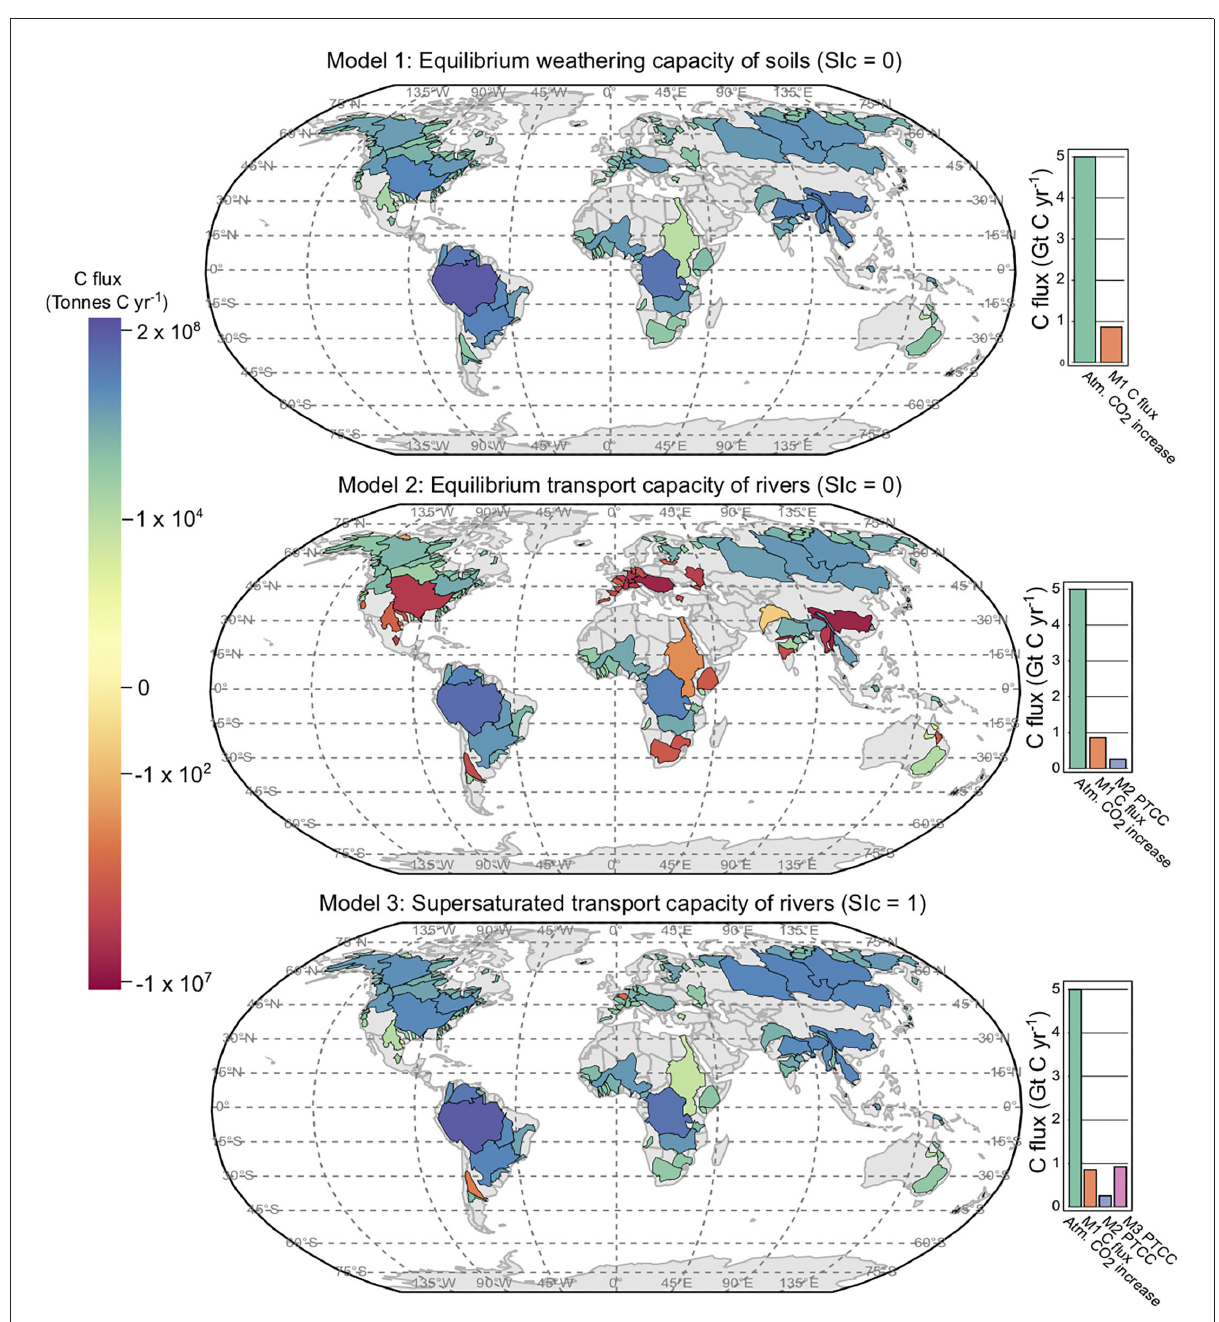
FIGURE2 Model 1, 2, and 3 results plotted per river basin. Model 1 shows the SDC per basin. Models 2 and 3 display PTCC (potential transport capacity of carbon) values. Marginal bar plots provide a comparison between the SDC of Model 1, and the PTCC of Models 2 and 3 in comparison to annual increases of C in the atmosphere from Friedlingstein et al.